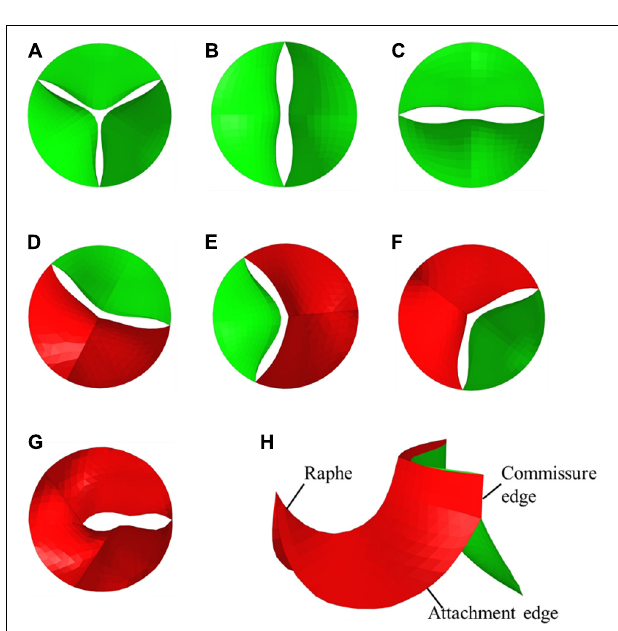
FIGURE 2 | Geometries of TAV and BAV (A) TAV, (B) Type 0 a–p, (C) Type 0 lat, (D) Type 1 L–R, (E) Type 1 N-L, (F) Type 1 R-N, (G) Type 2, (H) isometric view of BAV